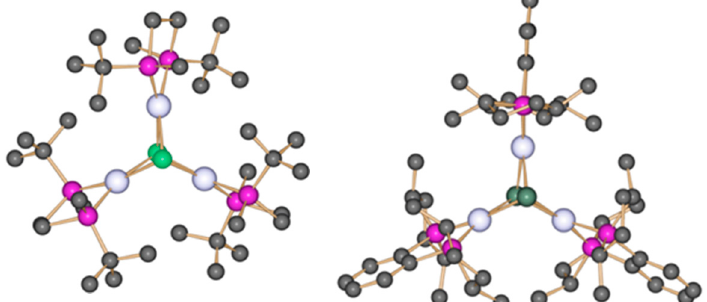
Figure 21. Molecular structures of the cations of [Rh 3 (( R , R )- t -Bu-BisP*) 3 ( µ 3 -Cl) 2 ] + , left, and [Rh 3 (( S , S )-